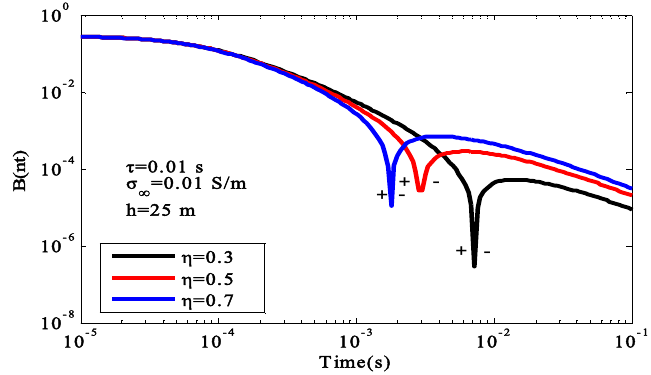
Figure 5. Influence of conductivity at infinite frequency on IP effect.